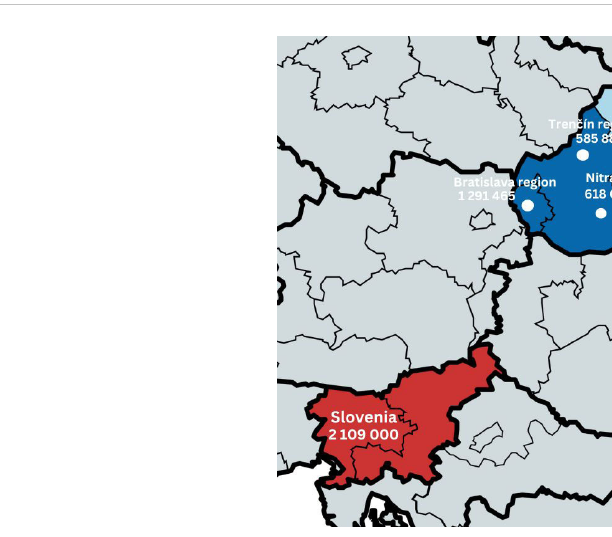
FIGURE 1 The map showing the origin of Slovak and Slovenian